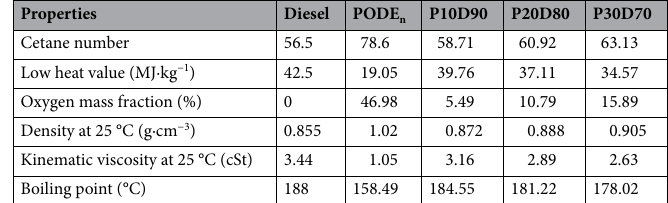
Table 2. Physical and chemical parameters of the